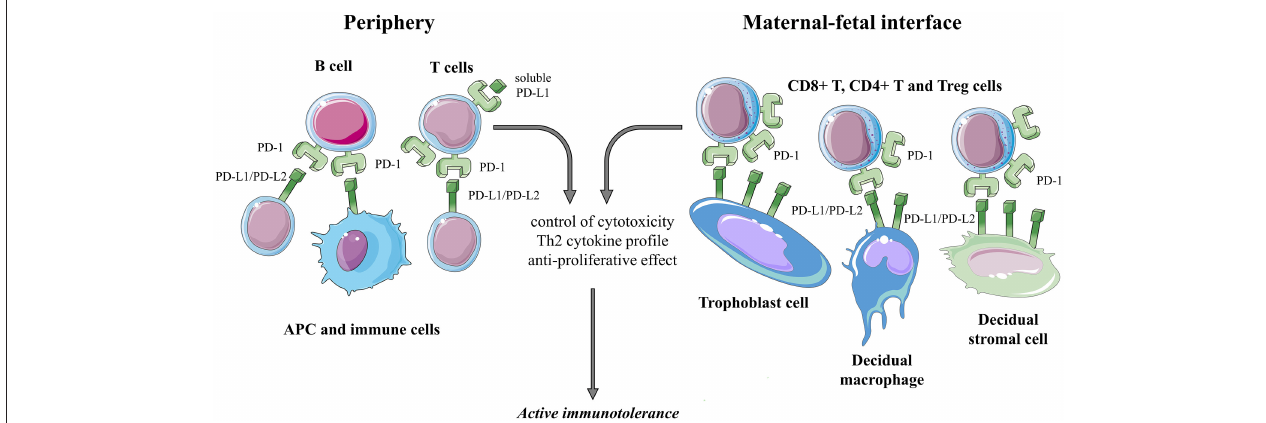
FIGURE 3 | Summarizing the possible role of the PD-1/PD-L1, PD-L2 pathway during human pregnancy.